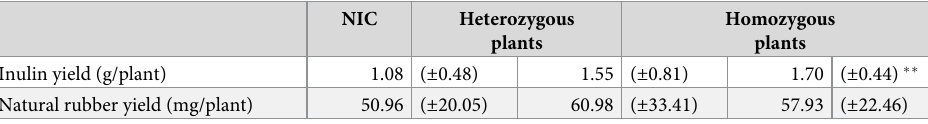
NIC Heterozygous plants